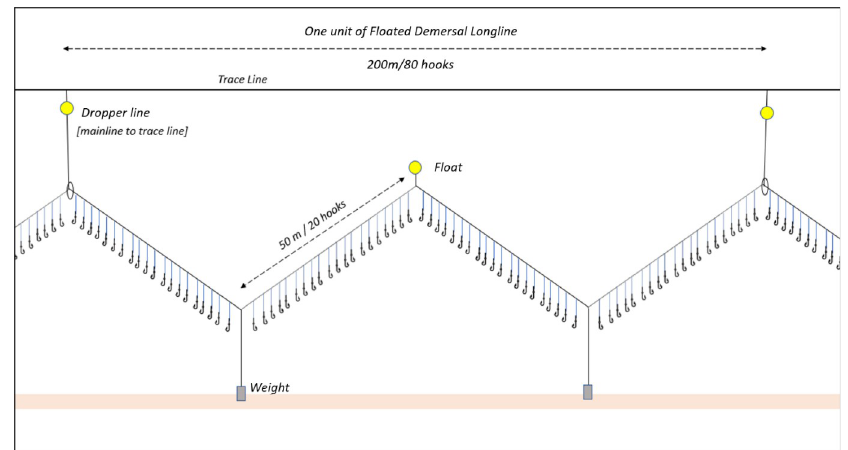
Fig 1. Schematic of floated-demersal longline. This ‘typical’ configuration is used to target European Hake in the North-East Atlantic fishery, composed by a sequence of floats, weights and dropper lines (connecting the main line– with hooks–to the trace line). A “unit” (or box) corresponds to 200m of line and 80 hooks, and a longline is comprised of up to 130 units in this fishery. Noting variation in some of the specific elements depending on fishing conditions and skipper